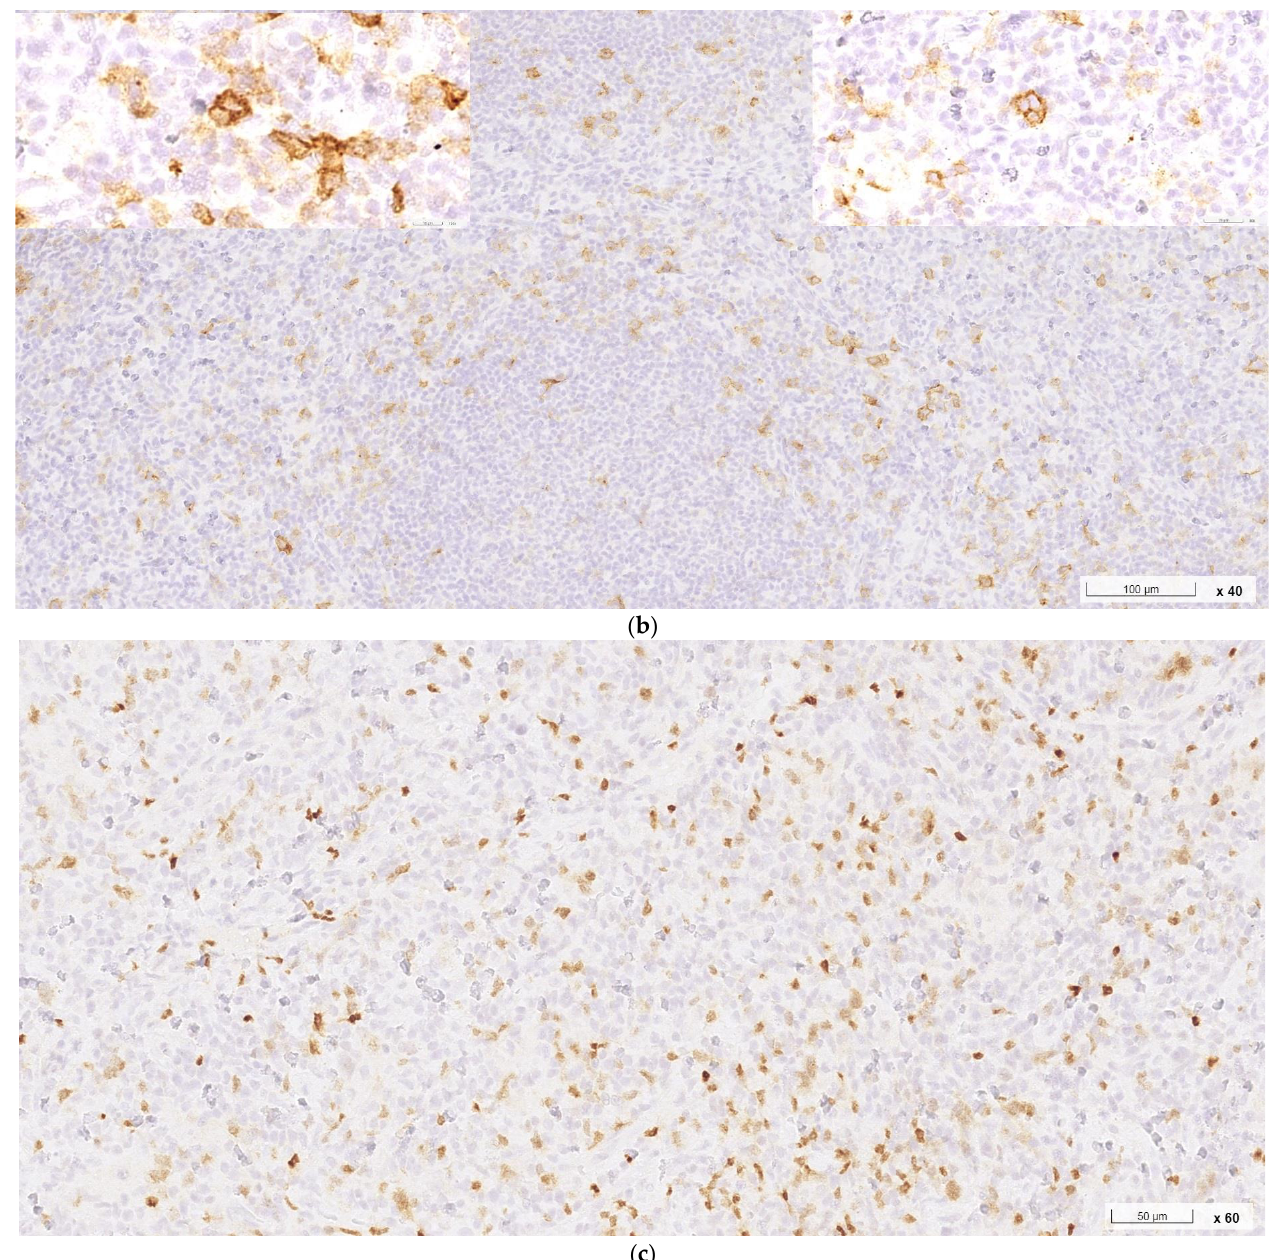
Figure 3. Immunohistochemical studies of an enlarged right cervical lymph node; obtained from his previous healthcare provider. ( a – c ): The Reed–Sternberg-like cells were positive for CD20, CD30, and PAX5, respectively .